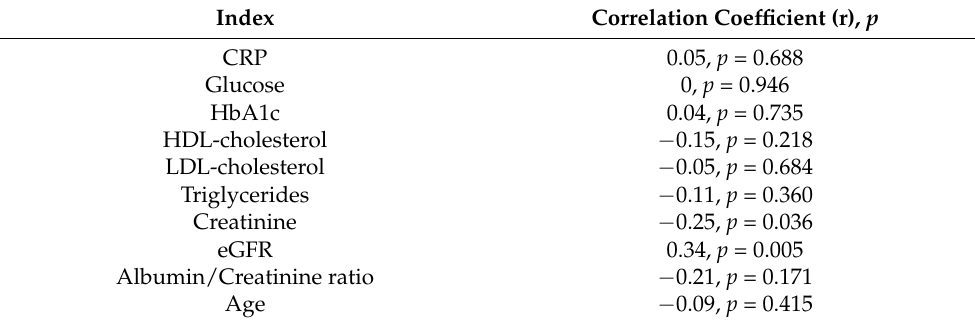
Table 3. Correlation between AGE10 and demographic data, inflammatory, metabolic, and kidney function indices.